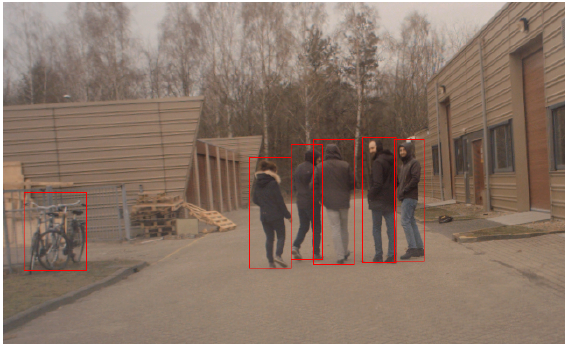
Figure 11. This detection contains a false positive since our detection method detected a bicycle as a VRU. Therefore, our tracker should select a hypothesis that assumes those bicycles are